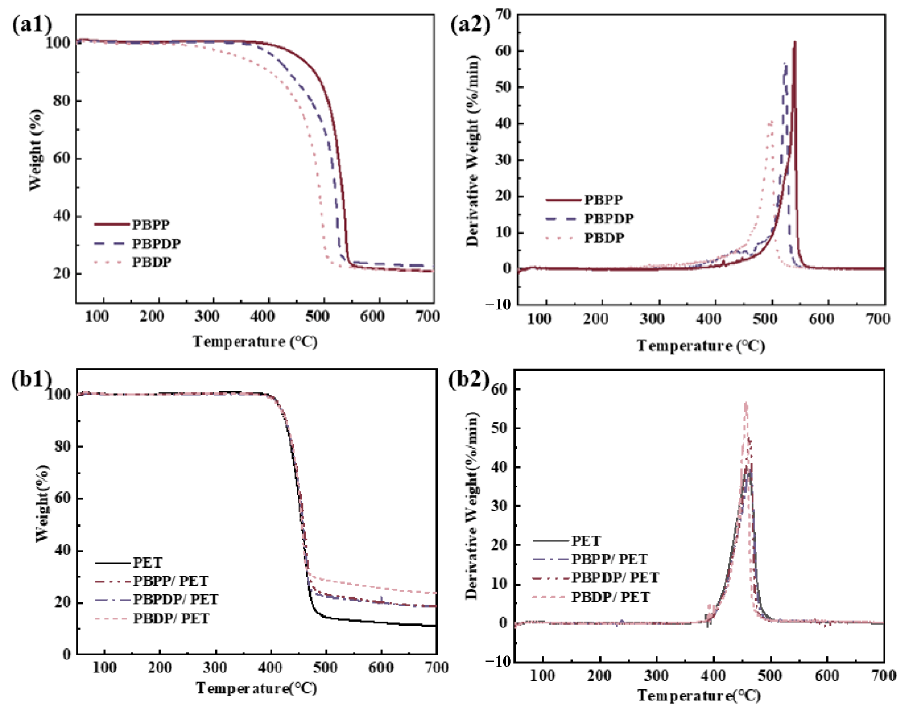
Figure 2. TGA and DTG curves of polyphosphates ( a1 , a2 ) and PET composites ( b1 , b2 ) in N 2 at- mosphere.